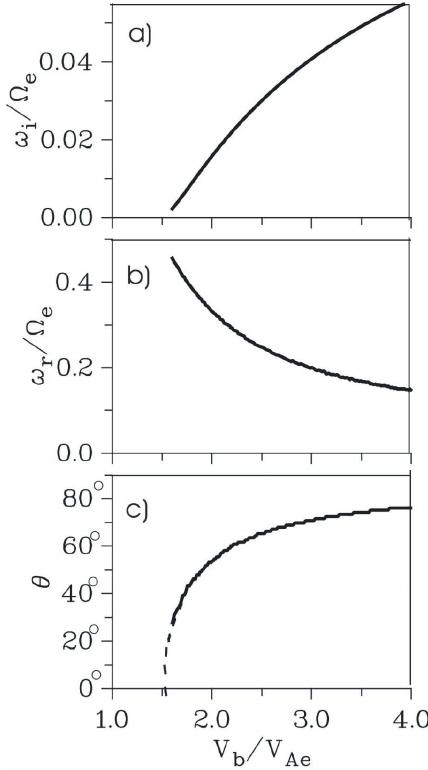
Fig. 5. Vlasov dispersion of beam-excited whistlers at oblique propagation ( θ = 70 ◦ ) for two values of electron plasma beta ( β e = 0 . 04-solid lines, β e = 0 . 2-dashed lines), showing the effect of ki- netic damping on the growth rate. The other parameters are: n b /n po = 0 . 05, V b /V Ae = 3 .